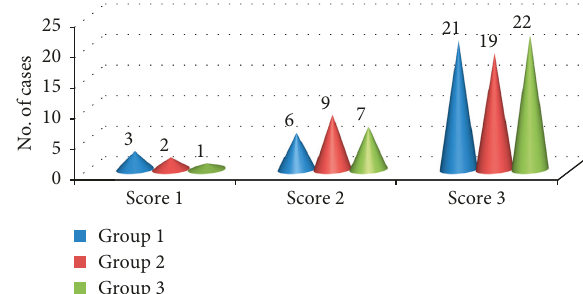
Figure 1: Caudal effectiveness score of the three drugs: group 1